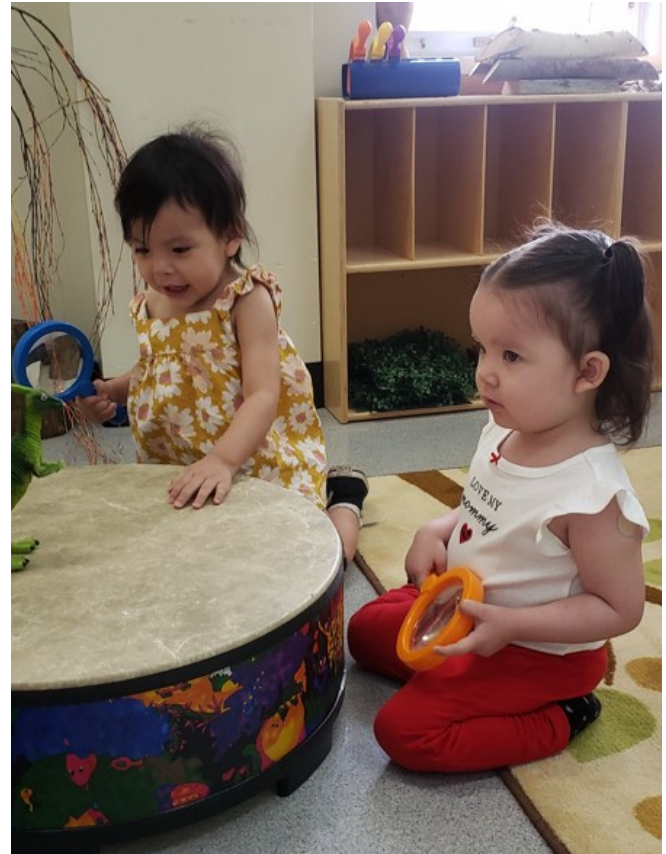
Figure 1. Drumbeats. Figure 1.